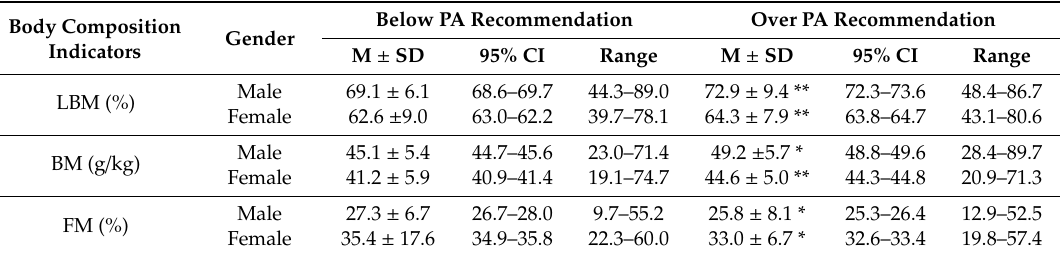
Table 2. The separate body composition indicators of participants with di ff erent physical levels. Body Composition Indicators